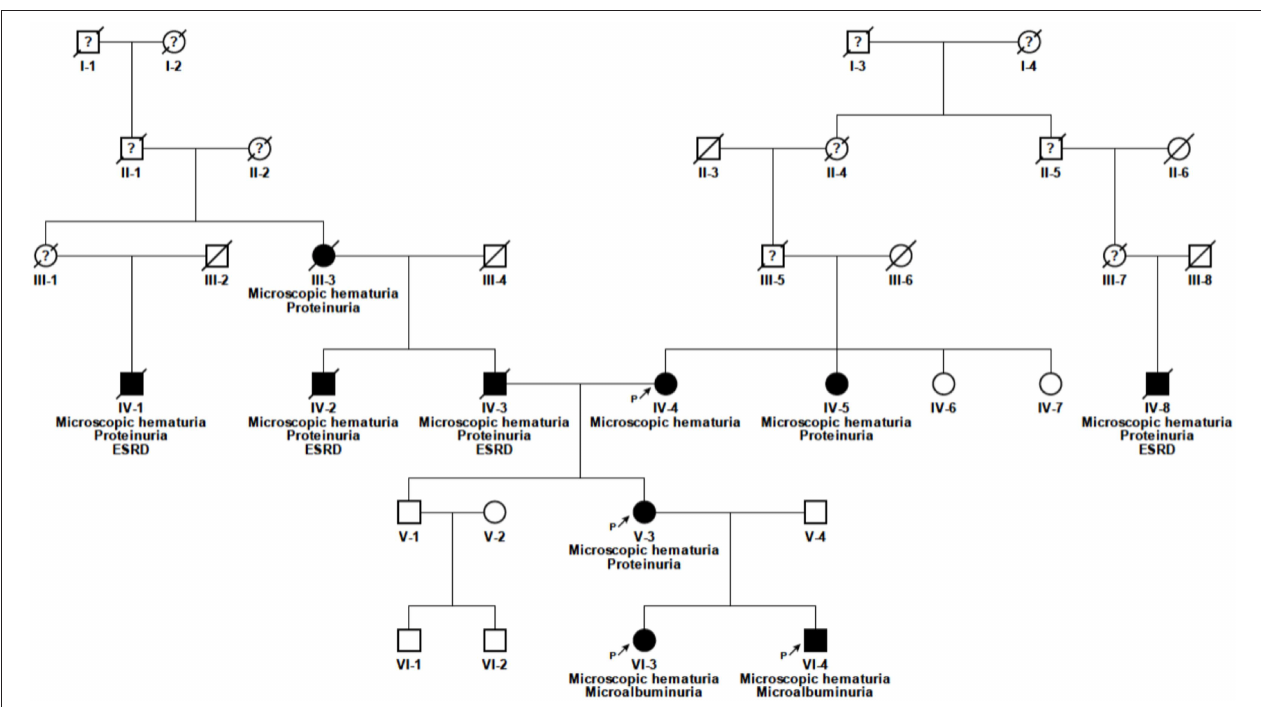
FIGURE 1 | Pedigree of the family. Solid symbols, affected individuals; circles, females; squares, males; n.d., no data available; P, proband; ?, unknown medical